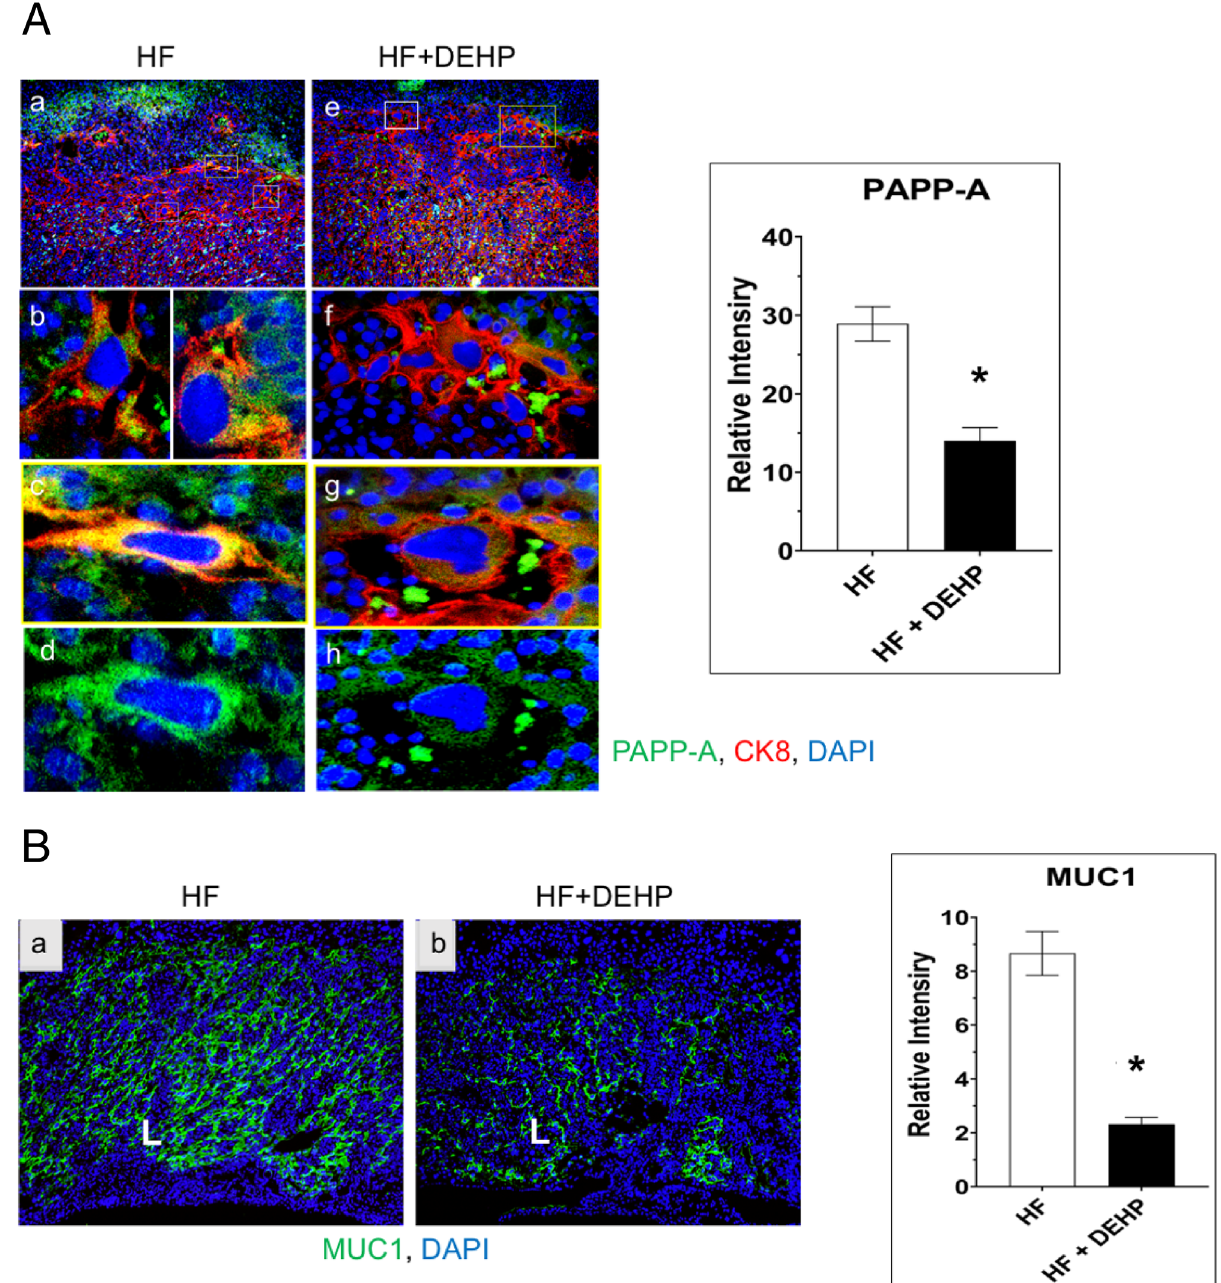
Figure 4. Exposure to DEHP and a HF diet attenuates expression of downstream targets of PPARγ. ( A ) Left. Placental sections from HF (panels a , b , c , and d ) and HF + DEHP (panels e , f , g , and h ) mice on D13 of pregnancy were subjected to immunofluorescence using PAPP-A (green) and cytokeratin 8 (red) antibodies. Note co-localization of cytokeratin 8 and PAPP-A (yellow) in the invading trophoblast cells at the border of the junctional zone and decidua of HF placentas, indicated by the boxed areas in panel ( a ). Panels ( b and c ) represent magnified images of trophoblast cells at the border of the junctional zone and decidua of HF placentas (4×) with co-localization of cytokeratin 8 and PAPP-A. Panel ( d ) shows trophoblast cells with PAPP-A but no cytokeratin 8 staining. In HF + DEHP placentas, the expression of PAPP-A was attenuated in the invading trophoblast cells at the border of the junctional zone and decidua, indicated by the boxed areas in panel ( e ). Panels ( f and g ) represent magnified images of trophoblast cells at the border of the junctional zone and decidua of HF + DEHP placentas (4×) with co-localization of cytokeratin 8 and PAPP-A. Panel ( h ) shows trophoblast cells with PAPP-A but no cytokeratin 8 staining. Right. Immuno-positive cells for PAPP-A were analyzed by ImageJ software. The values represent mean ± SEM of five independent samples. ( B ) MUC1 immunostaining of placental labyrinth from HF (panel a ) and HF + DEHP ( b ) animals on D13 of pregnancy (10×). Green indicates immunostaining with MUC1 and blue indicates DAPI. Right. Immuno-positive cells for MUC1 were analyzed by ImageJ software. The values represent mean ± SEM of five independent samples. Asterisks indicate statistically significant differences *p <